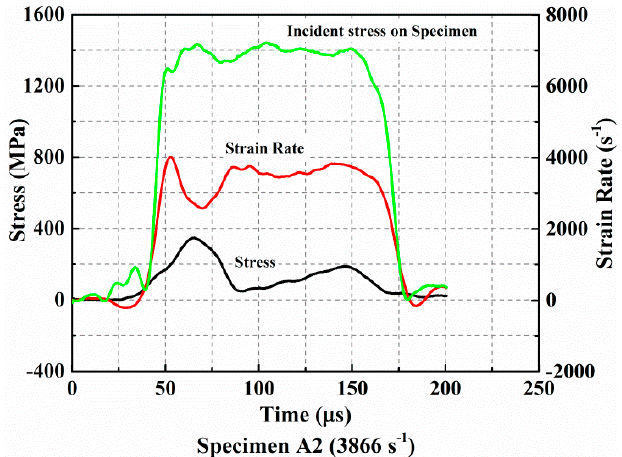
Figure 7. Evolution of the stress and strain rate curves during loading when the specimen has undergone complete failure.